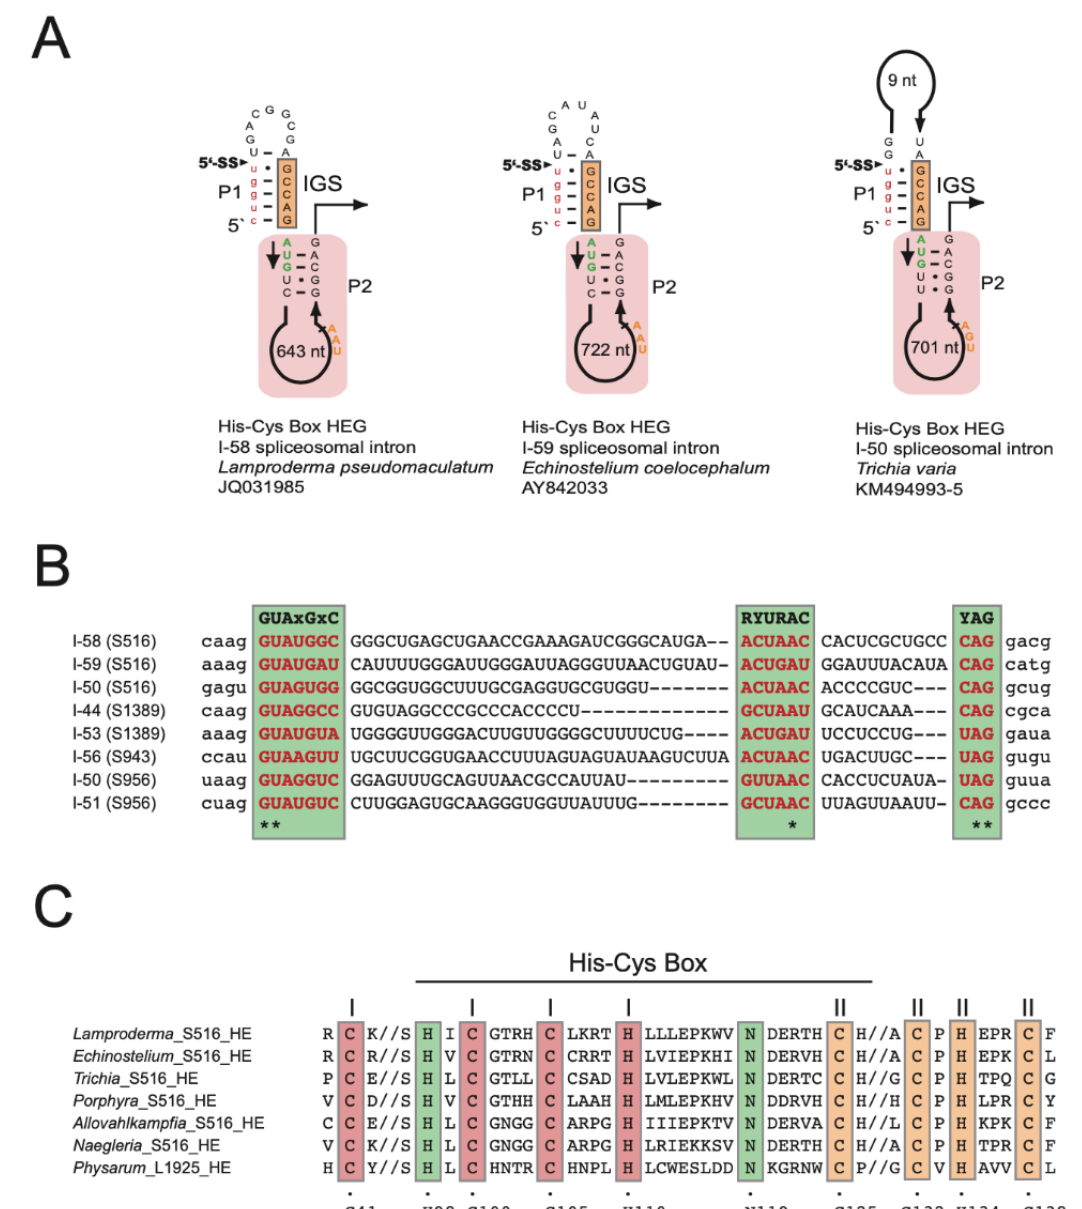
Figure 4. His-Cys Box homing endonucleases encoded by S516 group I introns. ( A ) Schematic organization of the S516 intron substrate domain hosting homing endonuclease genes (HEGs) in P2. 5 ′ SS, exon-intron splice site; IGS, internal guide sequence. The HEG start codons (AUG) and stop codons (UAA/UGA) are indicated. HEGs are interrupted by small spliceosomal introns (I-50, I-58, and I-59). ( B ) Sequence alignment of spliceosomal introns (uppercase letters) with some flanking HEG sequences (lowercase letters). Sequence motifs common to the mammalian spliceosomal intron consensus are indicated (green boxes), and invariable positions at the 5′ SS (GU), branch site (A), and 3 (cid:48) splice site (AG) are indicated by * below the alignment. ( C ) Amino acid alignment of His-Cys Box features of S516 homing endonucleases (HE). The Naegleria and Physarum HEs represent well- studied and experimentally verified His-Cys homing endonucleases. Conserved residues (boxed) corresponding to those presented in the Physarum L1925 HE crystal structure [52]. C41, C100, C105, and H110 are involved in zinc-binding motif I. C125, C132, H134, and C138 are involved in zinc- binding motif II. H98 and N119 are associated with the active